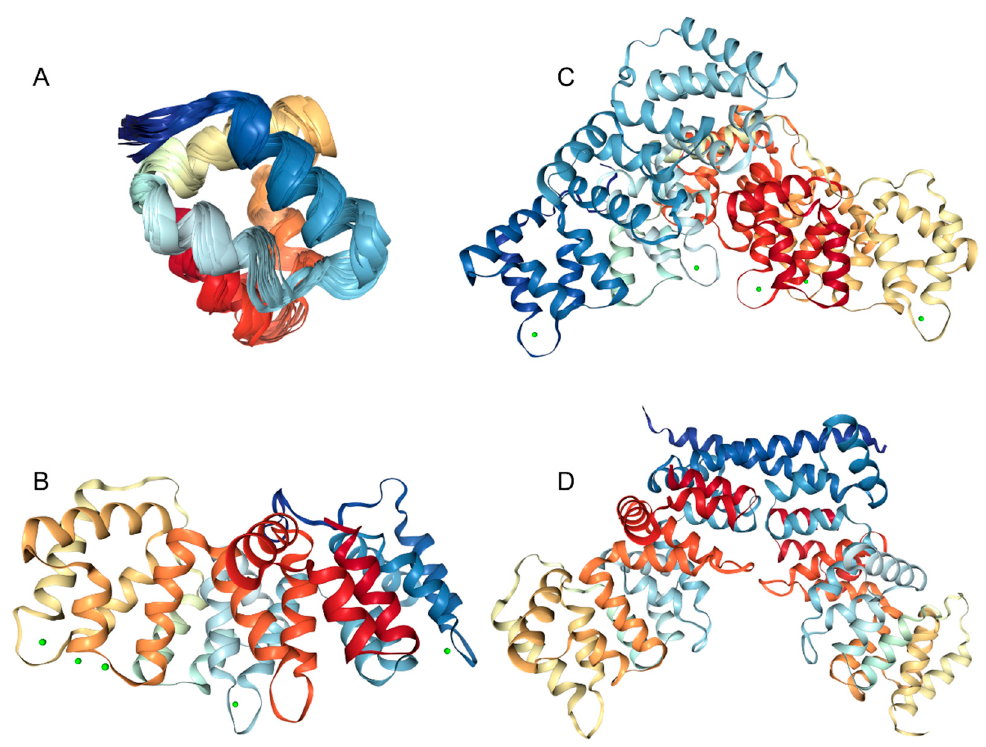
Figure 2. Structural characterization of human annexins. A . NMR solution structure of a single annexin repeat from ANXA1 (PDB ID: 1BO9). B . An X-ray crystal structure of the full-length ANXA3 containing four annexin repeats (PDB ID: 1AXN). C . An X-ray crystal structure of the